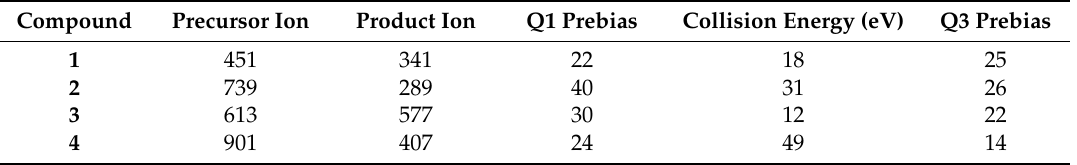
Table 2. MRM parameters for each (epi) catechin glycosides